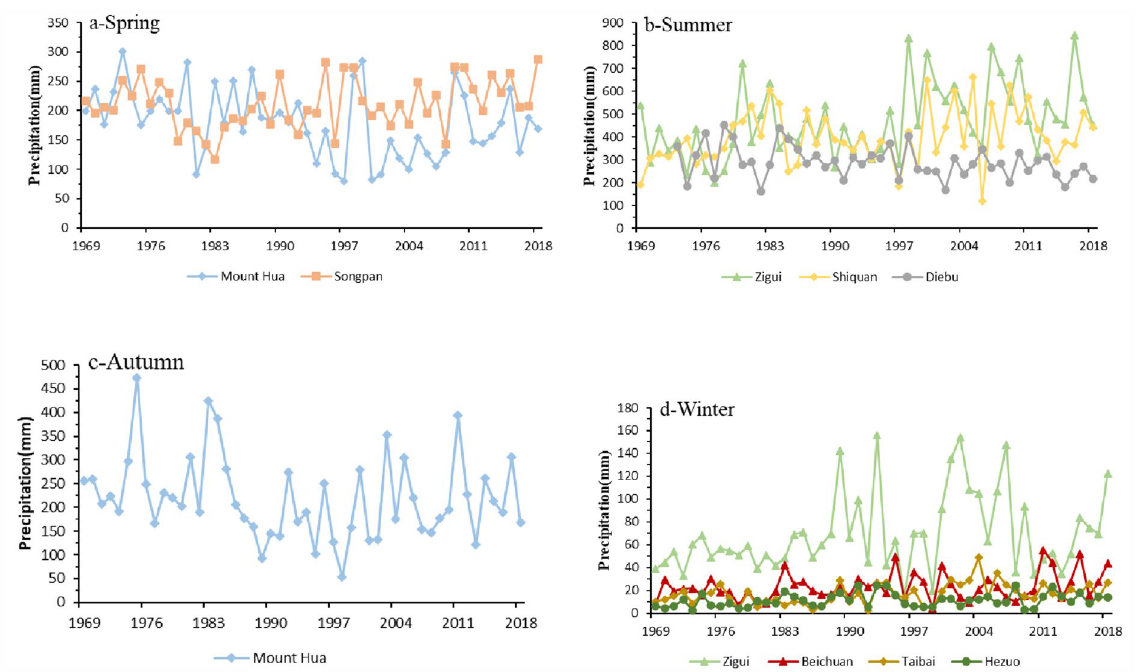
Figure 7. Stations with significant change in precipitation in different seasons in the Qinling–Daba mountains during 1969–2018: ( a ) spring, ( b ) summer, ( c ) autumn, and ( d )